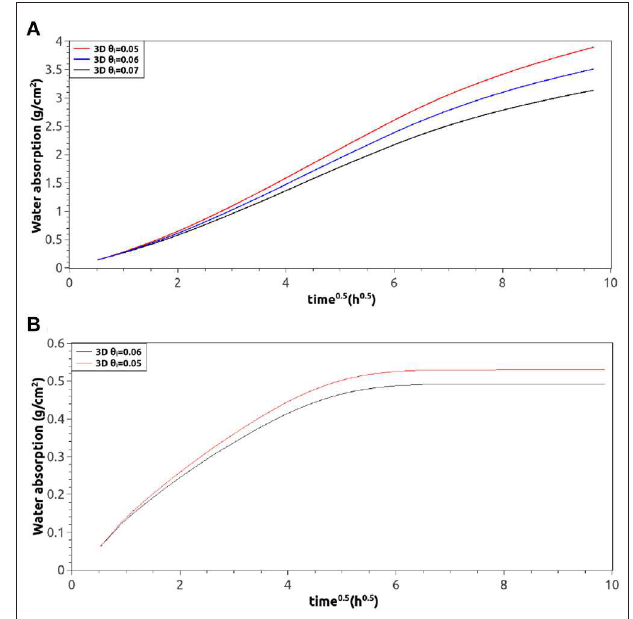
FIGURE 6 | 3D numerical water absorption profiles. (A) Profiles of case (b) in Figure 2 using different θ i , (B) profiles of case (a) in Figure 2 using different θ i